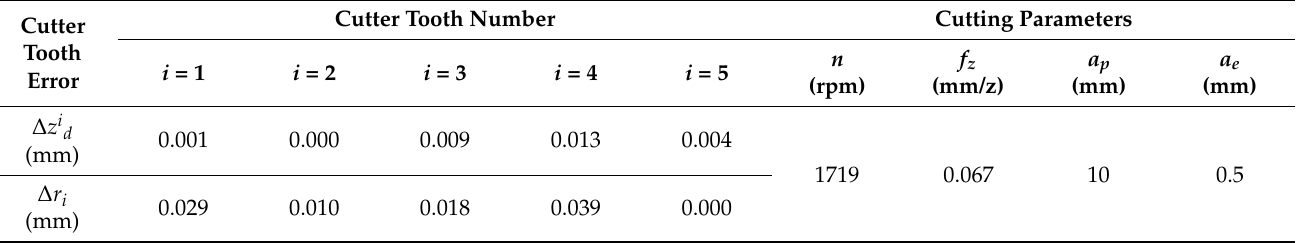
Table 3. Milling experimental parameters and cutter tooth error of the scheme 2.